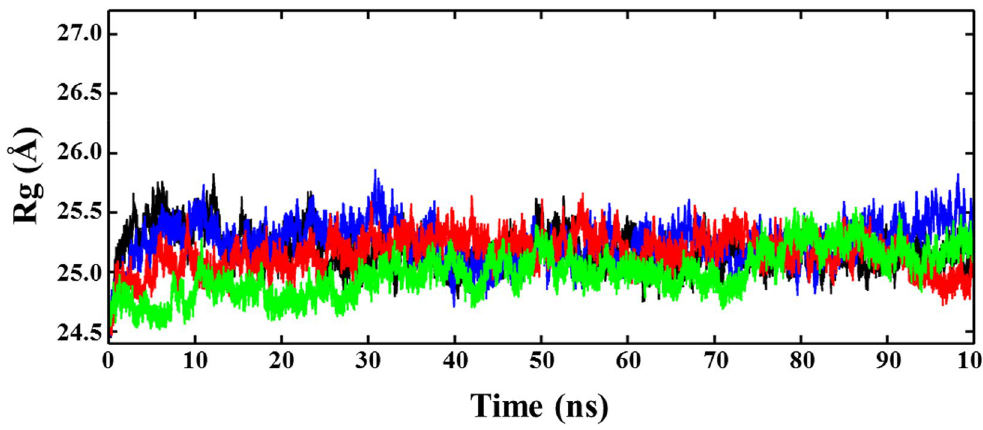
Figure 3. Time evolution plots of the radius of gyration (Rg) ofACE2 and protein–ligand complexes, ACE2-NF1, ACE2-NF12, and ACE2-NF13.